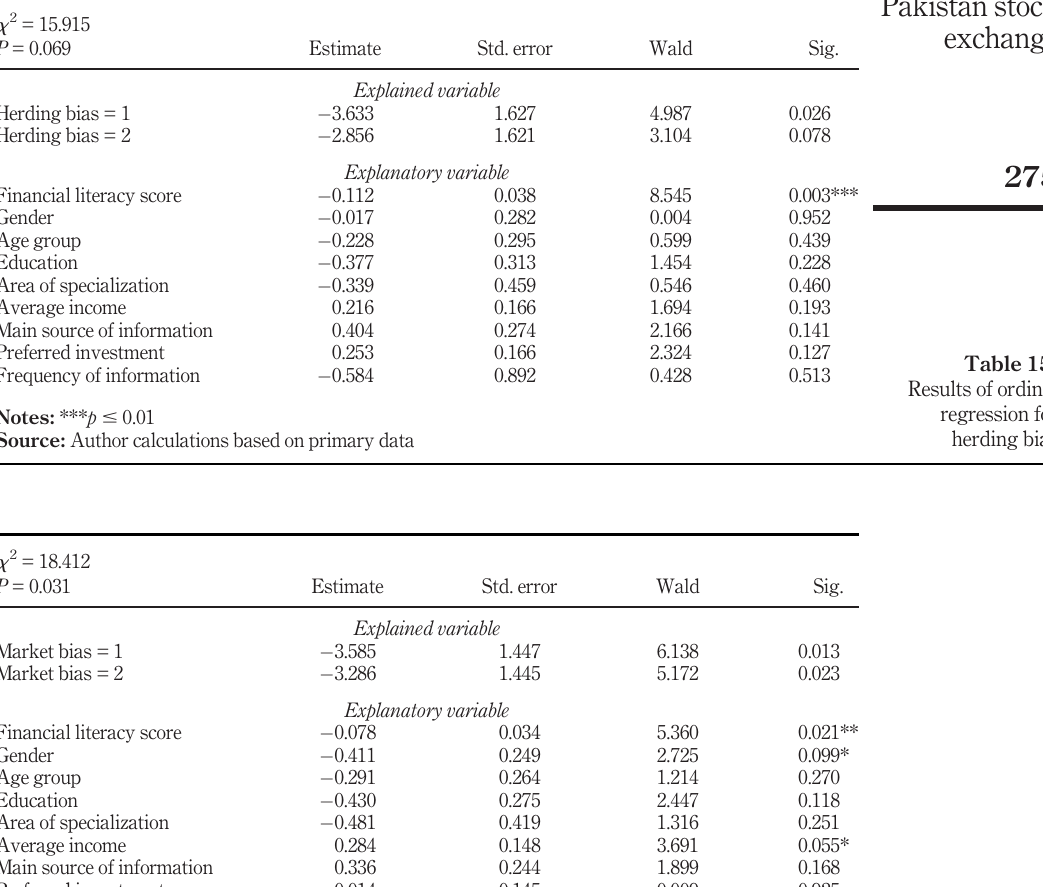
Table 16. Results of ordinal regression for